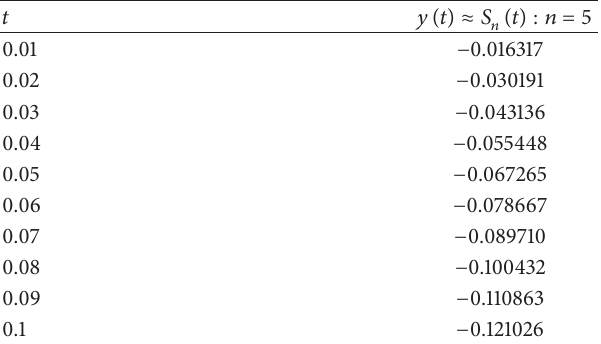
Table 2: Approximate solutions with the error bound |𝑅 0.9 5 (𝑡)| ≤ 5.480973 × 10 −8 in Example 1 obtained by GTSM for 𝛼 = 0.9 .